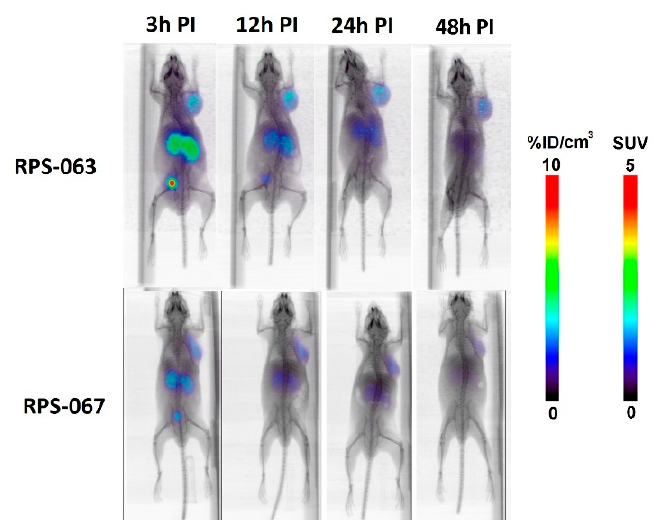
Figure 2. µPET/CT imaging of LNCaP xenograft tumor-bearing mice with [ 66 Ga]RPS-063 and [ 66 Ga]RPS-067 at 3 h, 12 h, 24 h, and 48 h post injection. Mice were injected intravenously with a bolus injection of 1.1 MBq ([ 66 Ga]RPS-063 or 5.4 MBq ([ 66 Ga]RPS-067). The total amount of ligand injected was 2.1 ± 0.2 nmol. Prior to imaging, the mice were anesthetized with isoflurane and then imaged for 30 min (3 h, 12 h) or 60 min (24 h, 48 h). The images were corrected for decay and for activity injected.